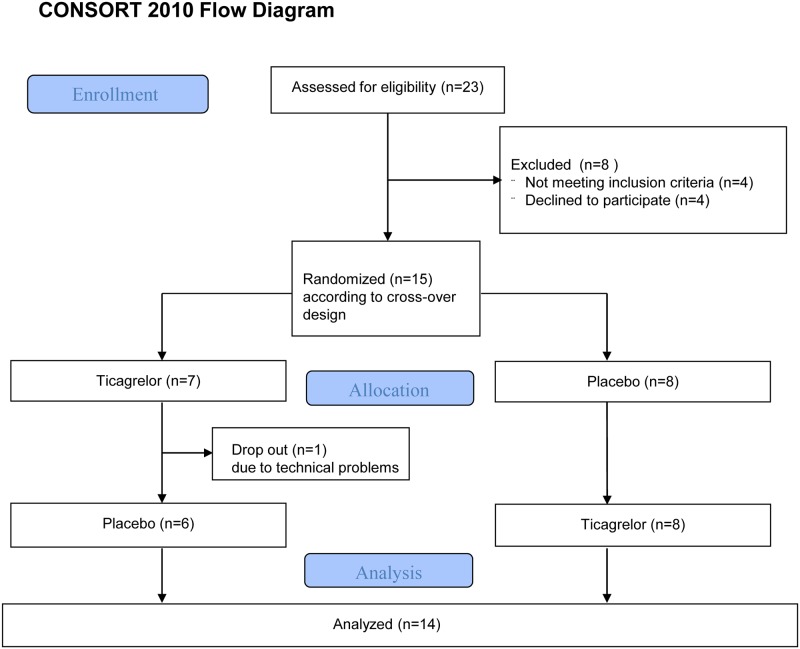
Study Flow chart.